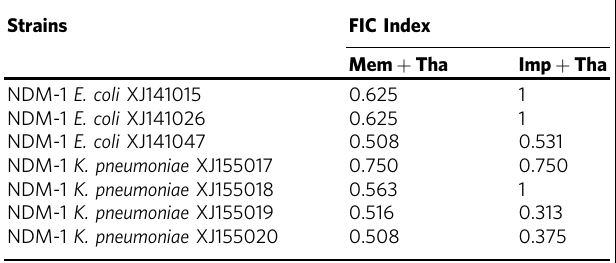
Table 2 FIC indices against NDM-1 clinical isolates